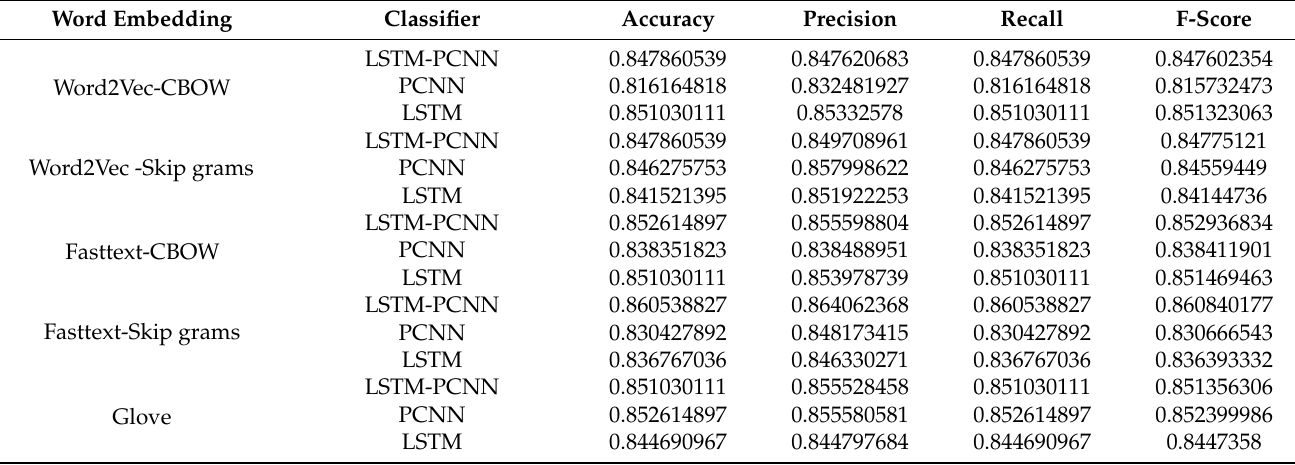
Table A2. The Median Values obtained using Various Classifiers with Three Dense